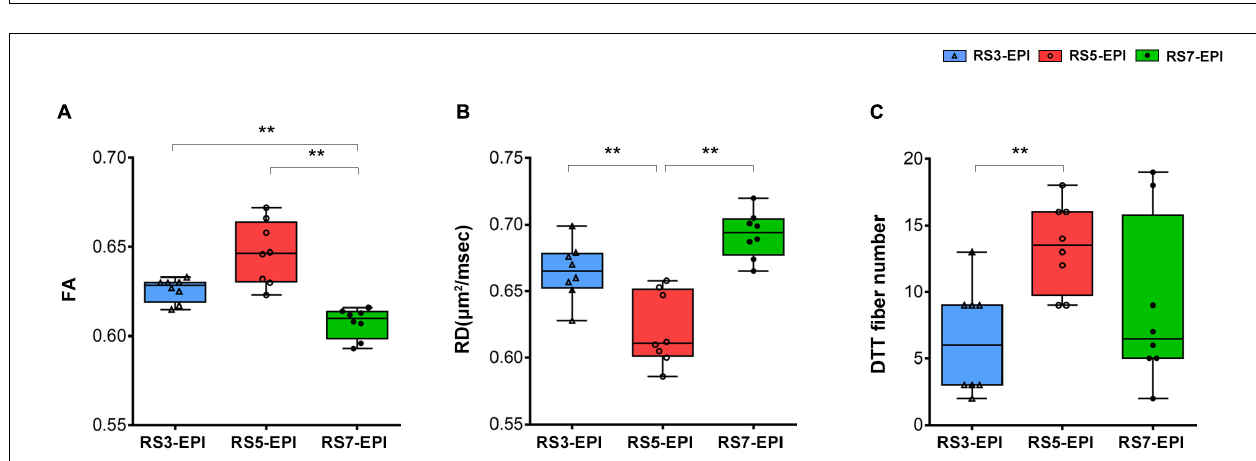
FIGURE 4 | Image quality scores for RS-3 EPI, RS-5 EPI, and RS-7 EPI. The chart showed the image quality scores rated by reader 1 (the more senior radiologist). The image quality scores of RS-5 EPI were superior to those of RS-3 and RS-7 EPI for better display of the nerve and lower artifacts of the ventral/dorsal margin and femur. ** P ≤ 0.017, post hoc analysis with Bonferroni corrected.